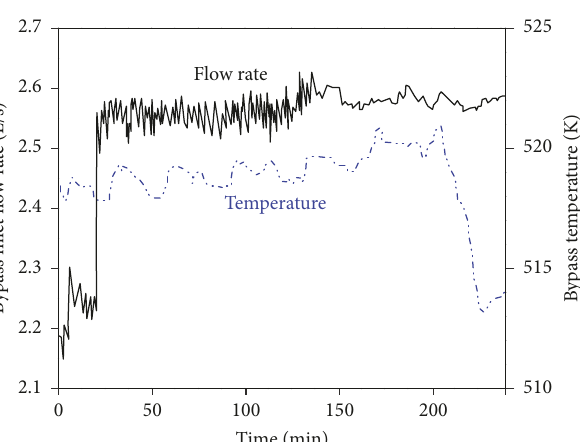
Figure 5: Boundary conditions of the bypass line used in the input code.